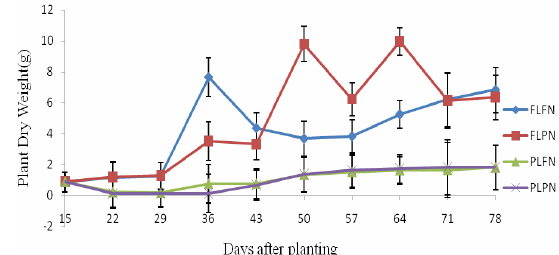
Fig. 7. Effect of light and nutrient stress on the total chlorophyll content